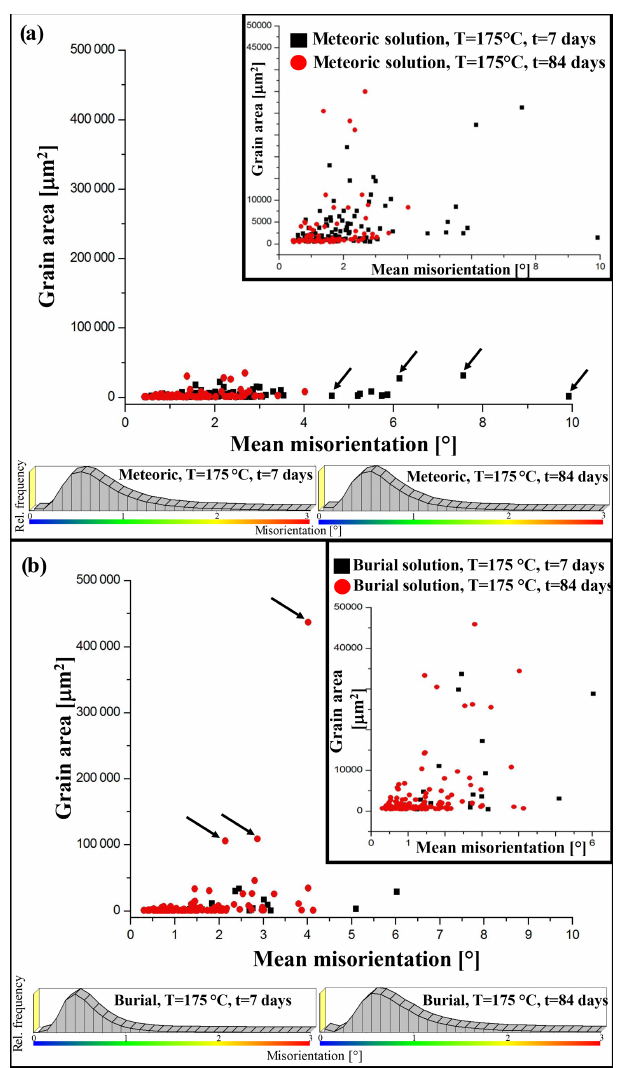
Figure 15. Grain area versus mean misorientation within individual grains obtained for newly formed calcite at alteration of Arctica is- landica aragonite in artificial meteoric (a) and in burial (b) solutions at 175 ◦ C and for 7 and 84 days, respectively. The Mg-containing (burial) alteration fluid induces the formation of large calcite grains that show a low degree of misorientation within the grains (b) , while with artificial meteoric solution, the solution that is devoid of Mg, significantly smaller grains are obtained. However, the latter oc- cur with a high mean misorientation within the individual, newly formed